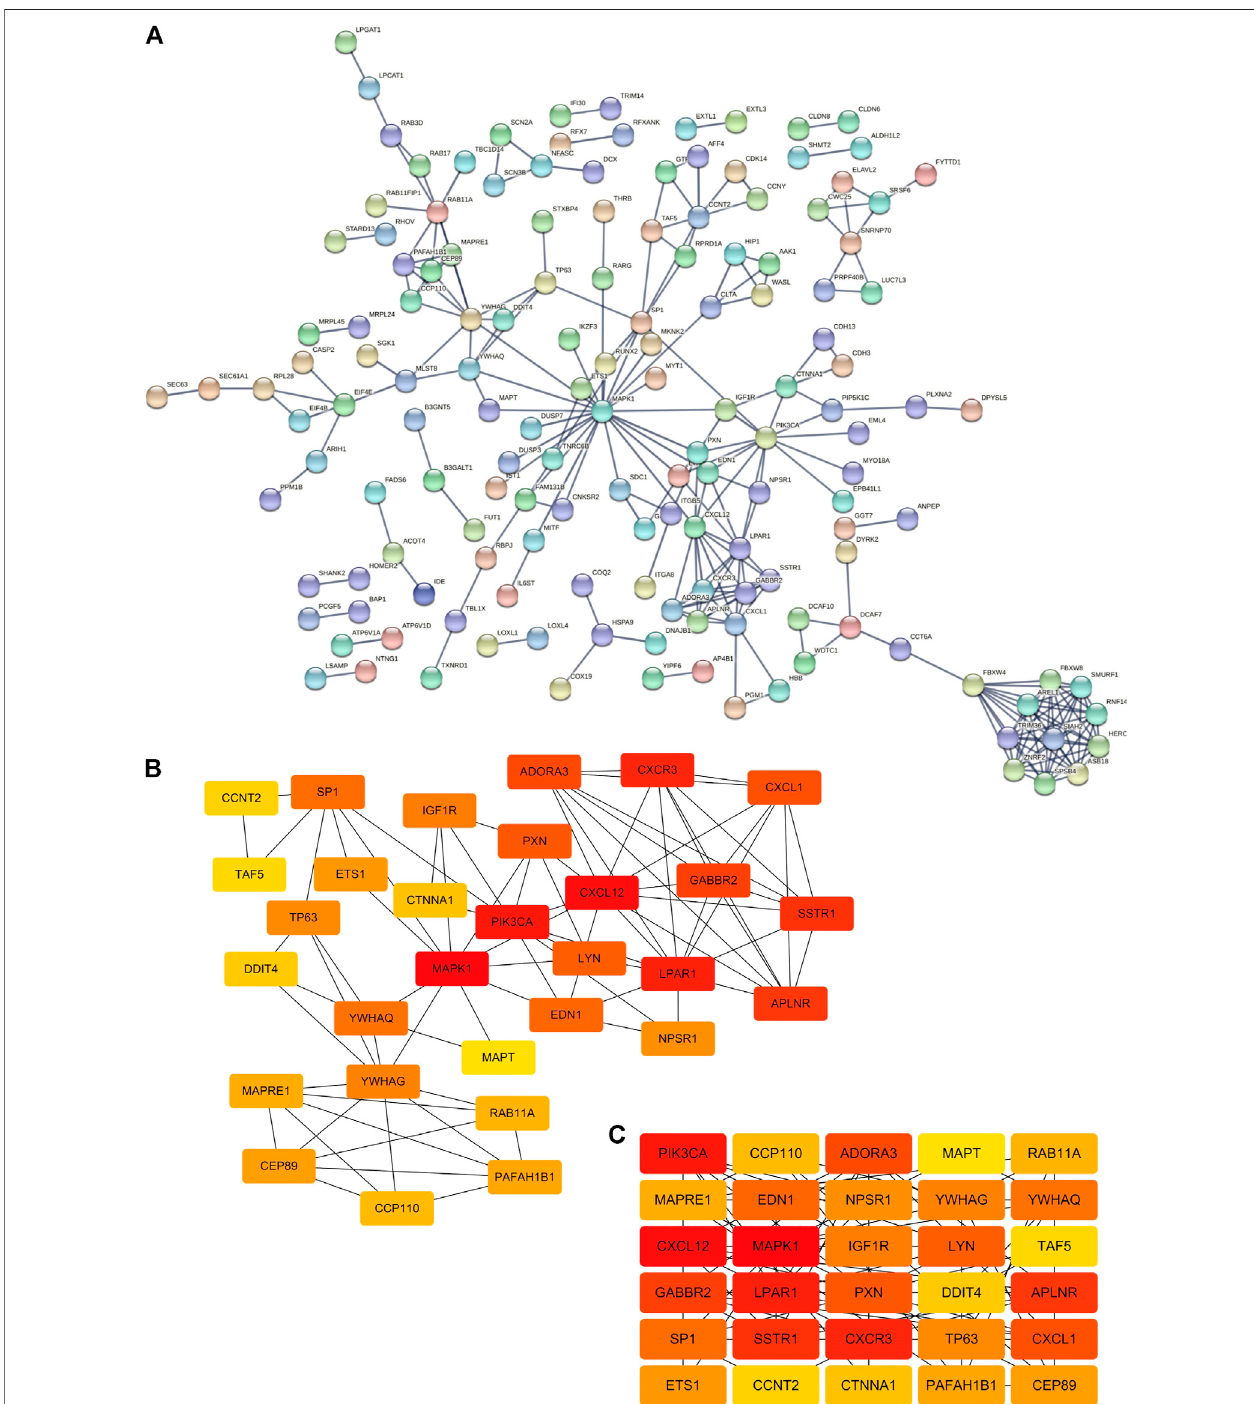
FIGURE 3 | Construction of the PPI network. (A) PPI network from the String online website. Each node represents a gene, and each edge represents the interaction between genes. Number of nodes: 395; number of edges: 254; expected number of edges: 211; average node degree: 1.29; PPI enrichment p -value: 0.00229. (B,C) Top 30 hub genes of the PPI network based on the EPC algorithm in the cytoHubba plugin by Cytoscape software.